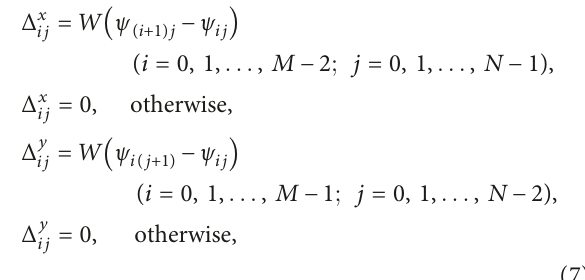
Figure 2: Specimen shape and loading